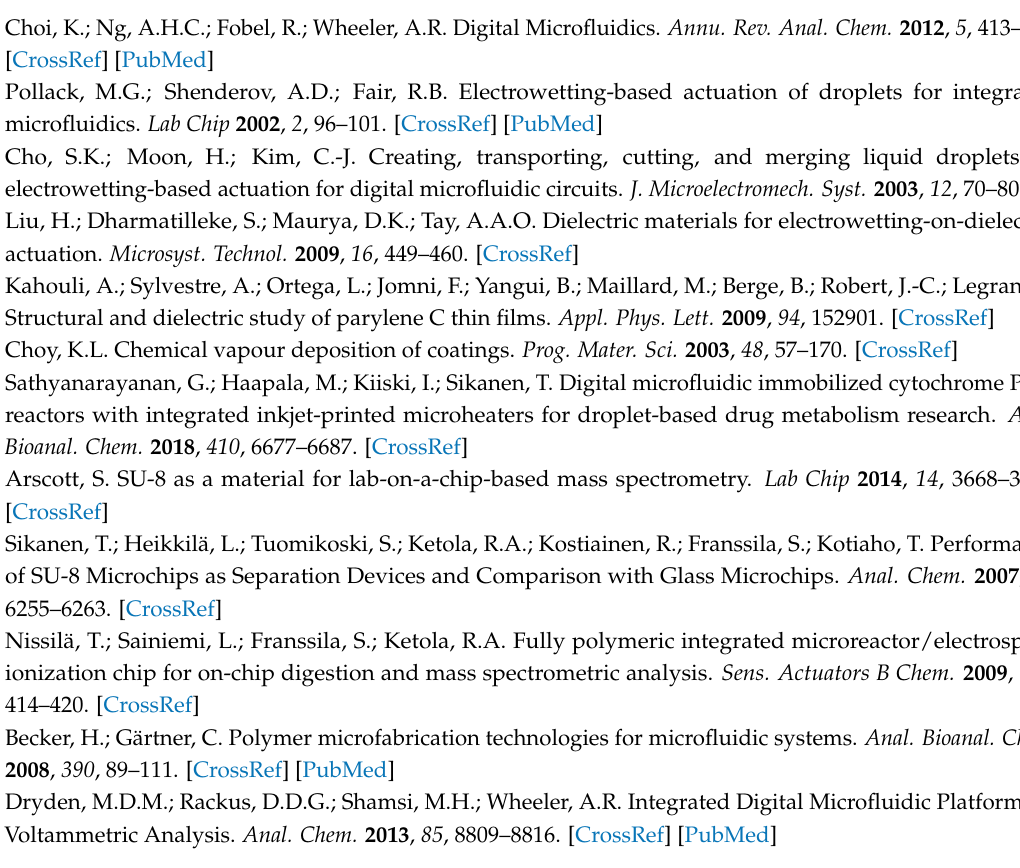
s1, Figure S1. Schematic illustrations of (a) DAPPI-MS analysis of samples precipitated onto the DMF bottom plate, and (b) the key functions of the heated nebulizer chip; Figure S2: Comparison of SU-8 and Ormocomp dielectric layers before and after use (in DMF, driving voltages (100–140 Vrms at 10 kHz); Figure S3: Extracted ion chromatograms corresponding to protonated testosterone ion ([M + H] + = 289.216) measured from eight parallel SU-8 spots following (a) first application of 70 pmol testosterone in methanol-water (1:1) per spot (fresh plate), (b) washing of the spots with methanol and water (cleaned plate), and (c) re-application of 70 pmol testosterone (cleaned and reused plate); Figure S4: Extracted ion chromatograms corresponding to protonated testosterone ion ([M + H] + = 289.216) measured from eight parallel SU-8 spots following (a) first application of 70 pmol testosterone in methanol-water (1:1) per spot (fresh plate), (b) washing of the spots with methanol and water (cleaned plate), and (c) re-application of 70 pmol testosterone (cleaned and reused plate); Video S1: Digital microfluidic actuation of an aqueous droplet into an octanol droplet in drug distribution